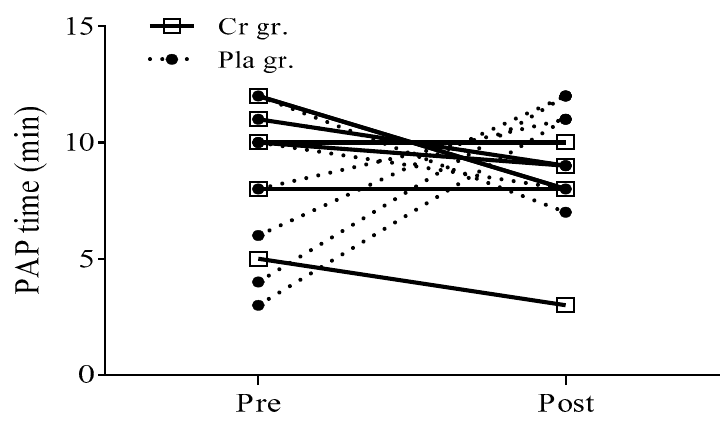
Figure 3. Optimal individual PAP time for each subject following creatine or placebo supplementation. Cr gr. = creatine group; Pla gr. = placebo group; Pre = pre-supplementation; Post = post-supplementation.